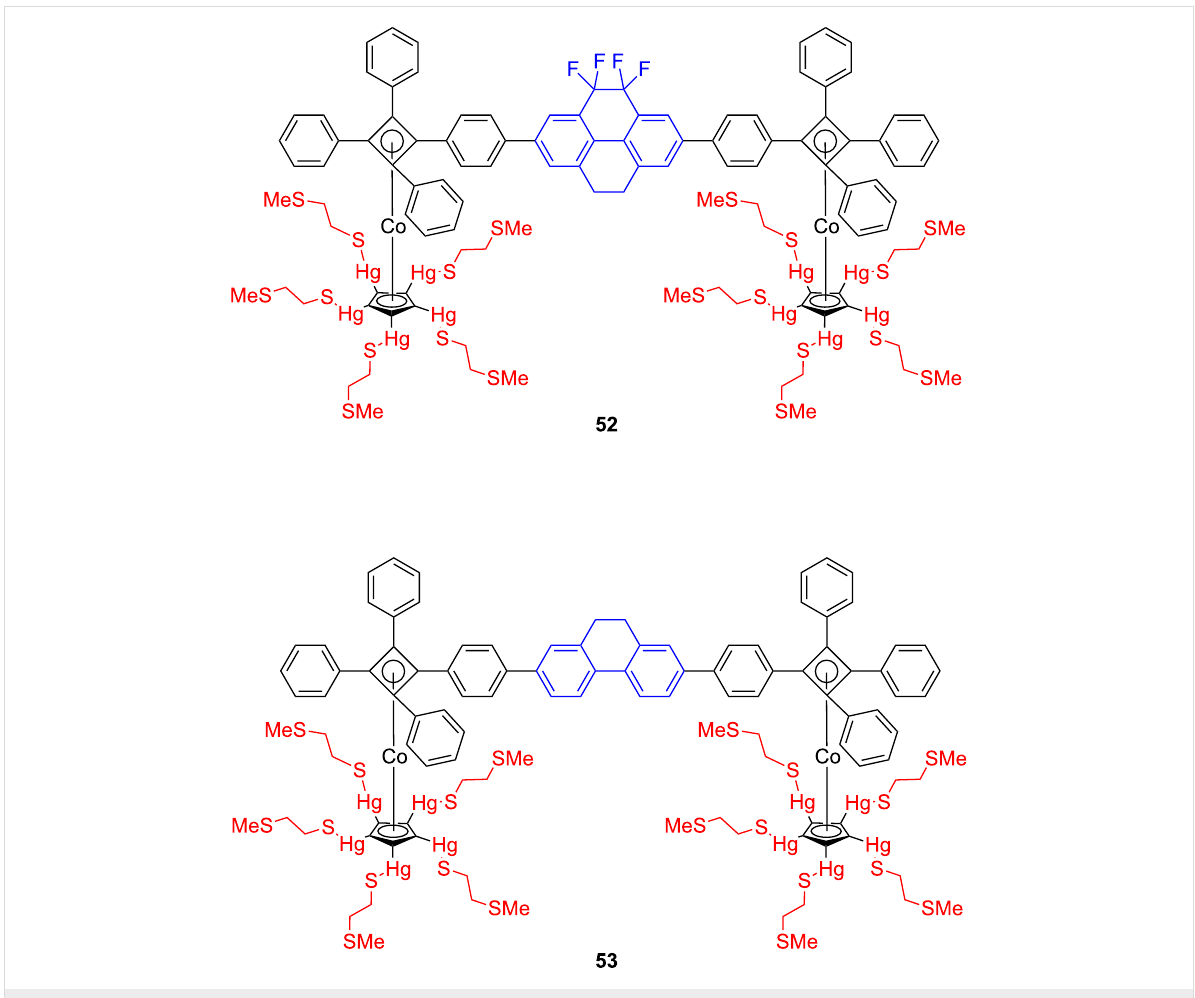
Figure 28: Dipolar and nonpolar altitudinal molecular rotors 52 and 53 .